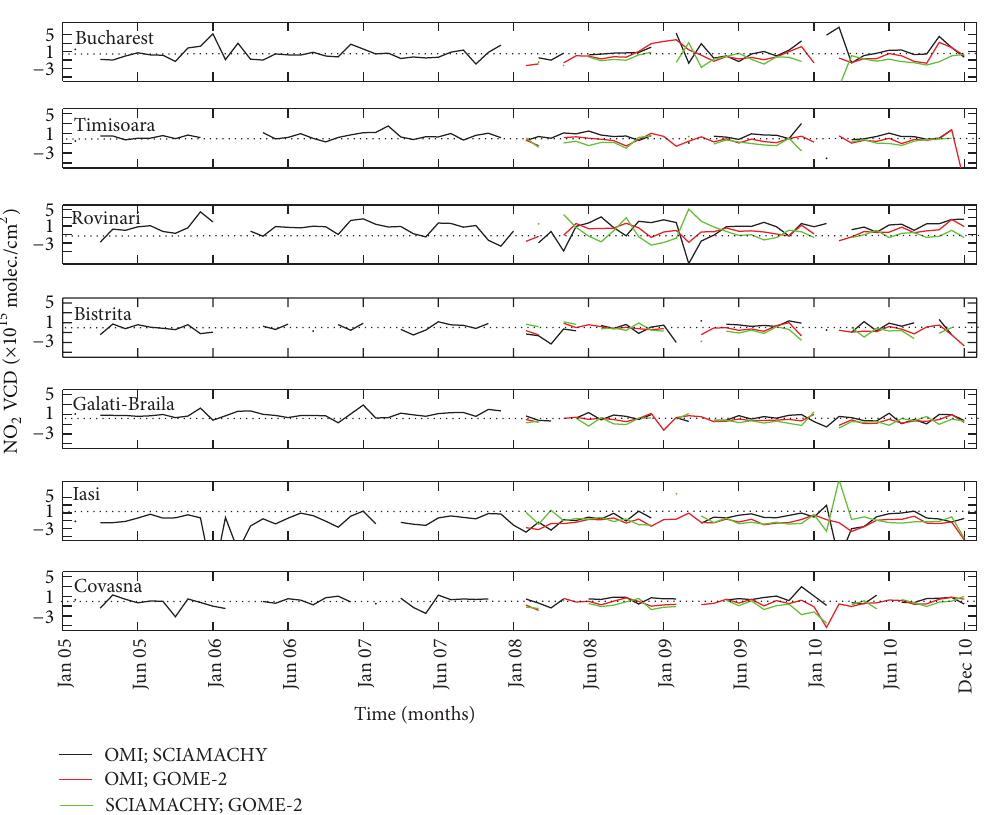
Figure 5: The differences between NO 2 satellite measurements over all selected